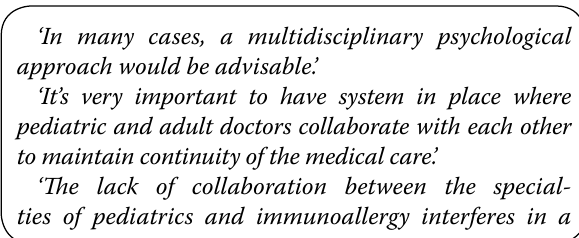
Fig. 1 Age of adolescents and young adults with allergy and asthma when healthcare professionals start the transition process and transfer to adult medical services. HCP, healthcare professionals; Paediatric HCP (n 449) looking after 0–18 years old patients; adult HCP (n = looking after 18 years old patients; all ages groups HCP (n 642). 1179 participants contributed to the statistical analysis. * Depending on the ≥ = developmental stage and readiness. ** Depending on their secondary school graduation; after school or after university; based on the